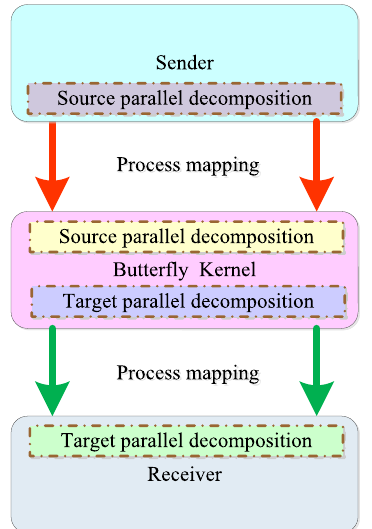
Figure 7. The butterfly implementation, which is composed of three parts: the butterfly kernel, process mapping from the sender to the butterfly kernel, and process mapping from the butterfly kernel to the